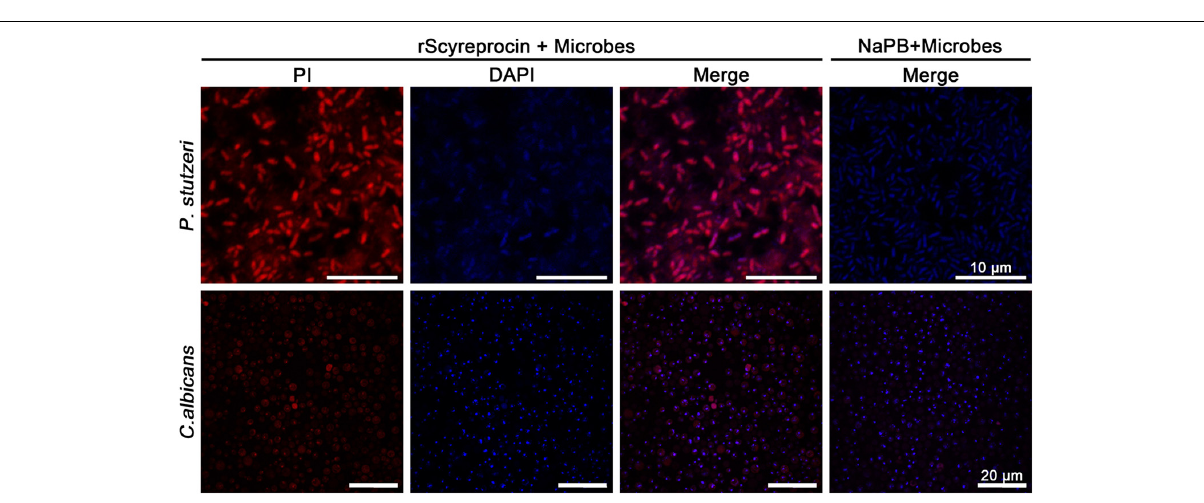
in vivo , marine medaka ( O. melastigma ) was challenged with a semi-lethal dose of V. harveyi (LD50, Supplementary Figure 7 ). After 2 h of bacterial challenge, different amounts of rScyreprocin were injected into the fish. The survival rate of the control group decreased to 40% at 24-h post-bacterial injection, whereas the protein injection control groups (without bacterial challenge) showed a 100% survival rate. The survival rate of the experimental groups receiving rScyreprocin injection was increased to 80% ( Figure 8C ). Thus, rScyreprocin